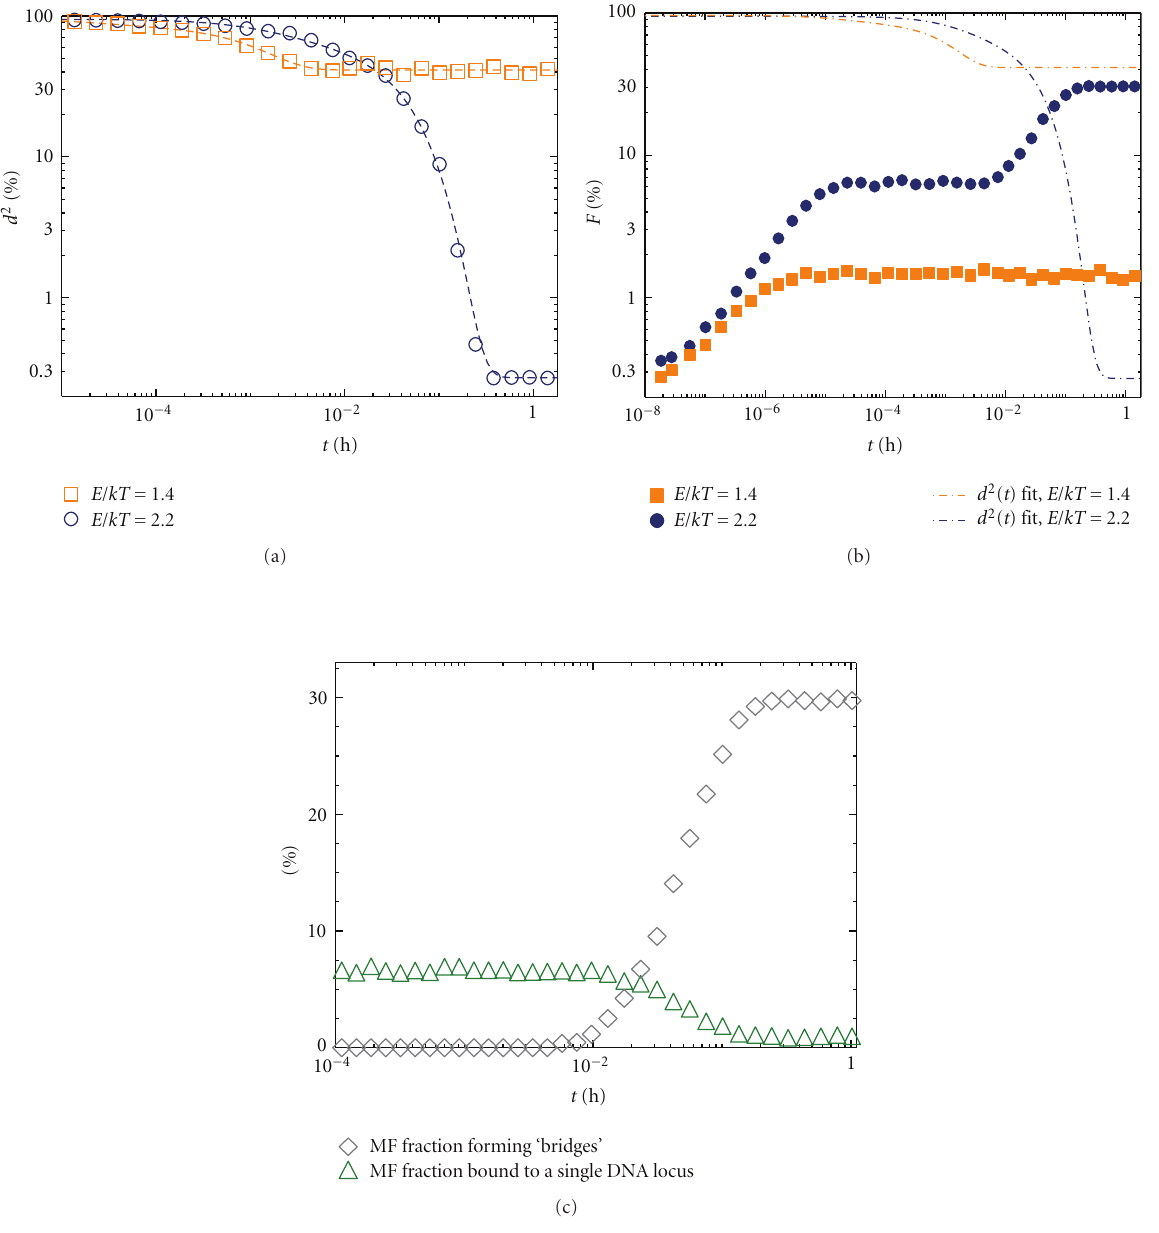
Figure 2: A couple of DNA loci colocalizes by increasing the MF-BS interaction energy E. (a) The normalized mean square distance d 2 is shown as function of t for two values of the interaction energy E between the Molecular Factors (MFs) and the Binding Sites (BSs). DNA loci start at a distance of the order of the containing volume size ( d 2 ∼ 100%). Then, for E/kT = 1 . 4 (orange square markers), d 2 saturates at the Brownian value ( ∼ 40%), while, at E/kT = 2 . 2 (blue circle markers), an e ff ective attraction appears, so strong to produce DNA colocalization at equilibrium ( d 2 ∼ 0%). (b) Together with the fit function for d 2 ( t ) (dashed lines), the mean fraction of MFs attached to a single DNA locus, F ( t ), is plotted. F (0) does not depend on E , since MFs were initially distributed at random in the lattice. Subsequently, F ( t ) reaches a first plateau, which is due to the MF binding to the single DNA locus and is, obviously, higher with larger E . Yet, while at lower energy ( E/kT = 1 . 4, orange square markers) this first plateau is also the thermodynamic equilibrium value for F ( t ); if E/kT = 2 . 2 (blue circle markers), F ( t ) rises to a second plateau, just when d 2 ( t ) exponentially decreases to ∼ 0. Actually, at this value of E , at equilibrium, some additional MFs bind both DNA loci to form thermodynamic stable “bridges”(see Figure 1), which keep them together. This is illustrated in (c), where the MF fraction bind to both DNA loci (gray diamonds) and to a single DNA locus (green triangles) is plotted as function of t for E/kT = 2 . 2 (the sum of these two curves gives F for E = 2 . 2kT, see (b)). Here an MF concentration c = 0 . 2% is present, with n 0 = 24 BSs within each DNA